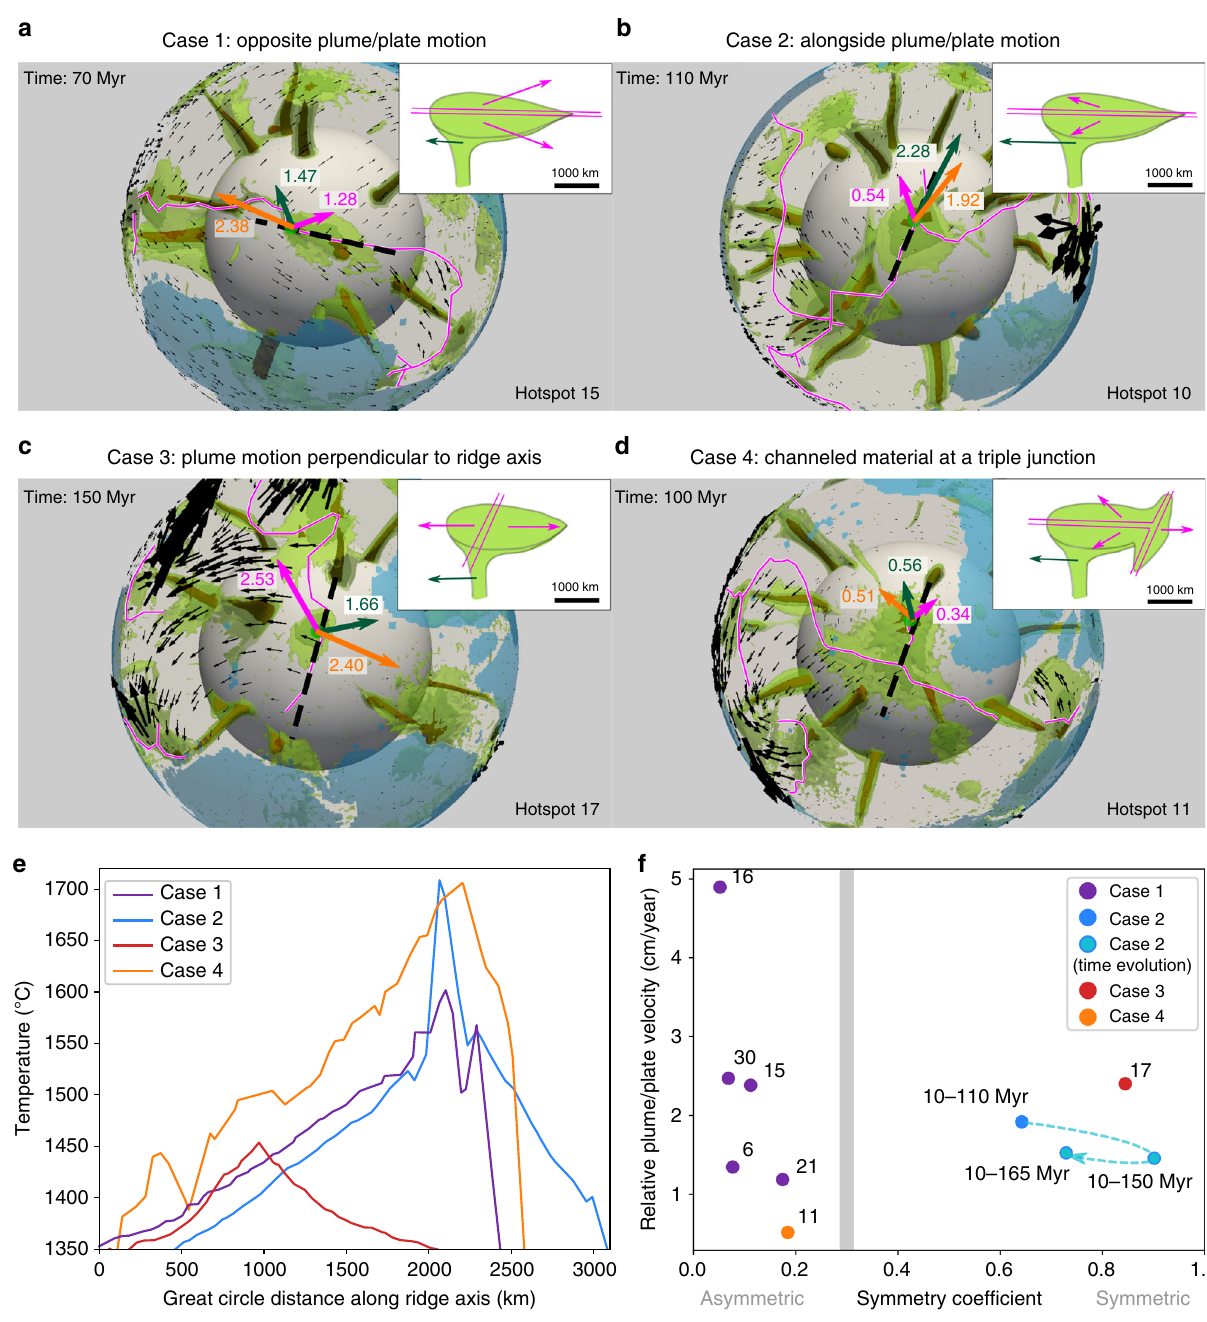
Fig. 3 Modeled kinematic scenarii of the interaction between a plume and a ridge system. a – d Snapshots of four modeled cases of the relative motion between a ridge system (magenta lines) and a mantle plume (outlined by the light green (1390°C), dark green (1480°C), and brown (1700°C) isotherms) in a global mantle convection model self-generating plate-like tectonics. Transparent green circles show the location of the plume thermal maximum. Colored arrows centered on the plume with magnitudes in cm/yr correspond to the plume absolute velocity (dark green), the average plates velocity within 500km of the plume center (magenta) and the relative velocity between the plume and the average plates velocity (orange). Black arrows scale with surface plate velocities and blue transparent areas show the location of continents. Insets are schematic diagrams of the corresponding kinematic cases. e Temperature pro fi les across the plume waist at 100km depth and along the modeled ridge (black dashed lines in a – d ). f Magnitude of the relative velocity between plumes and plate as a function of the symmetry of the temperature pro fi les of corresponding plumes (Supplementary Fig. 14). Symmetry coef fi cients correspond to the ratio of the extent of the thermal anomaly on each side of the corresponding plume thermal maximum. Numbers correspond to plume IDs. The vertical grey bar corresponds to the asymmetry observed at the Azores. Source data are available in the Open Science Framework repository and this can be estimated assuming Fe 2 O 3 /TiO 2 = 0.5 or assuming a constant dominantly characterized by Ti content >1 wt% (Supplementary Fig. 1d). As redox condition in the magmatic source (Fe 2 + / ∑ Fe = 0.9 or 0.8). We tested such, alternative adoption of a Ti-dependent redox condition is unlikely to affect our calculation toward more elevated T P . Consistently, a more oxidizing ratio of different hypotheses. Results are given in Supplementary Figure 1. Uncertainties that arise by calculating FeO using Fe 2 O 3 /TiO 2 = 0.5 instead of FeO/FeO T = 0.9 Fe 2 + / ∑ Fe = 0.8 will decrease FeO in the primary magma, yielding lower MgO propagate to uncertainties in mantle T P lower than 30°C for high-Ti type lavas and lower mantle T P but such general decrease will not change our general (TiO 2 > 1 wt%) up to 60 °C for low-Ti types (TiO 2 < 0.5 wt%). MORBs are conclusions because it involves the whole set of data.